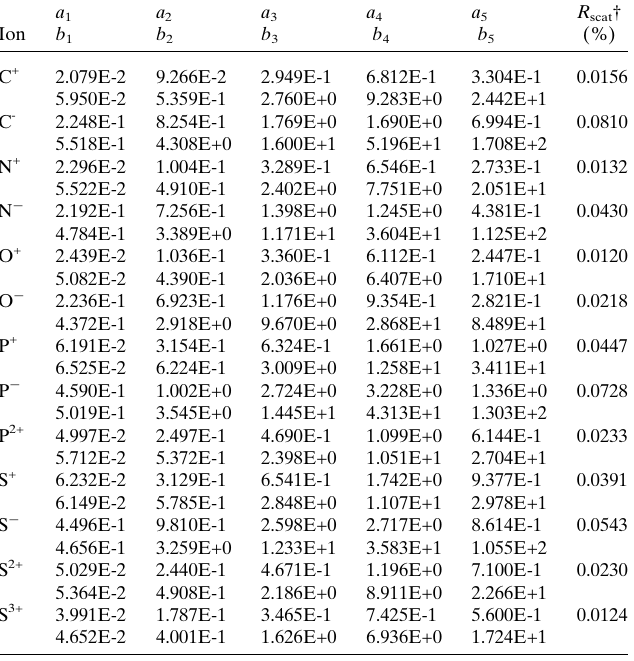
Table 4 Parameterization of electron scattering factors of ions for the five Gaussians plus a charge term